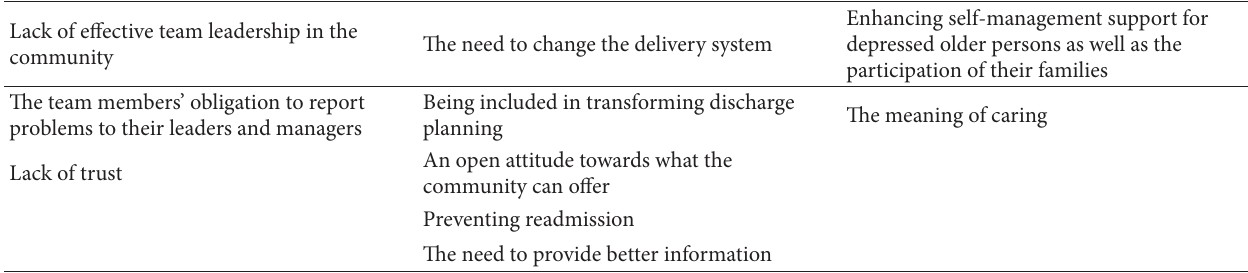
Table 1: Themes and subthemes that emerged in interdisciplinary team collaboration during the discharge of depressed older persons. Lack of effective team leadership in